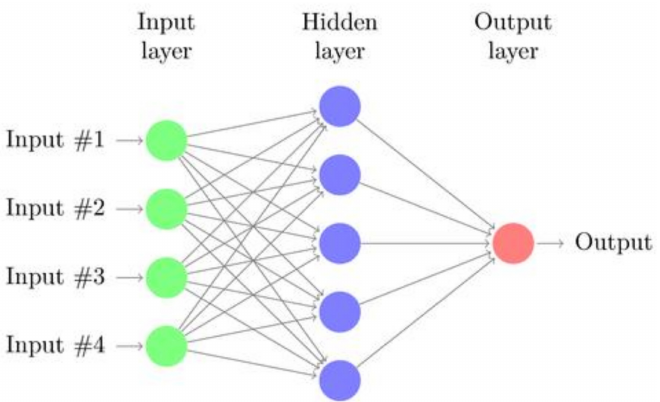
Figure 5. Basic artificial neural network (ANN) structure.